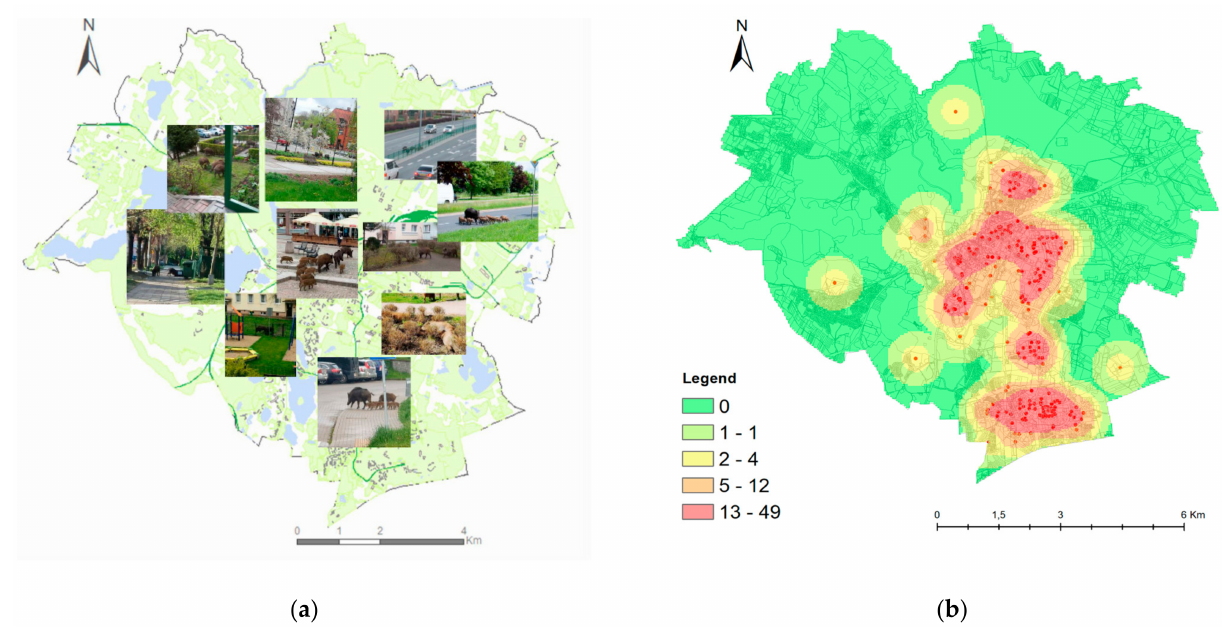
Figure 8. The maps depicting wild boar activity in the city of Olsztyn between March and October 2020 (( a ) type of wild boars’ activities; ( b ) wild boars’ concentration in the city). Source: own